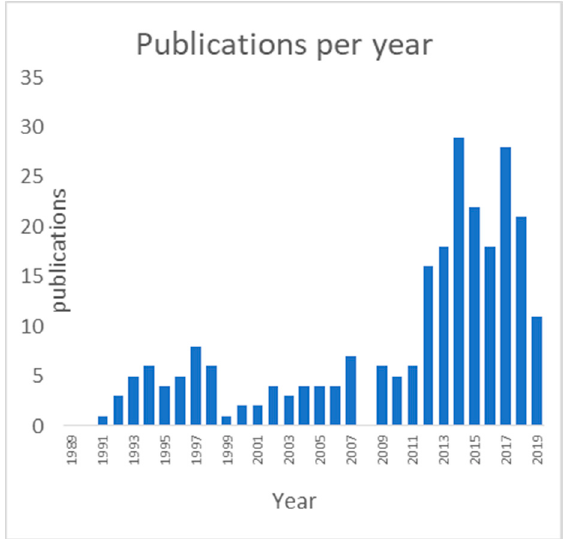
Figure 1. Publications per year reporting on reactions involving isocyanide reactant using palladium catalysis.